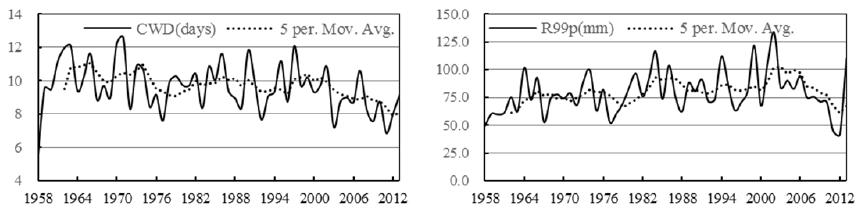
Figure 2. Trend of annual average extreme precipitation indices (CWD/R99p) in Yunnan Province from 1958 to 2013. (Dashed line is the 5-years moving average.)